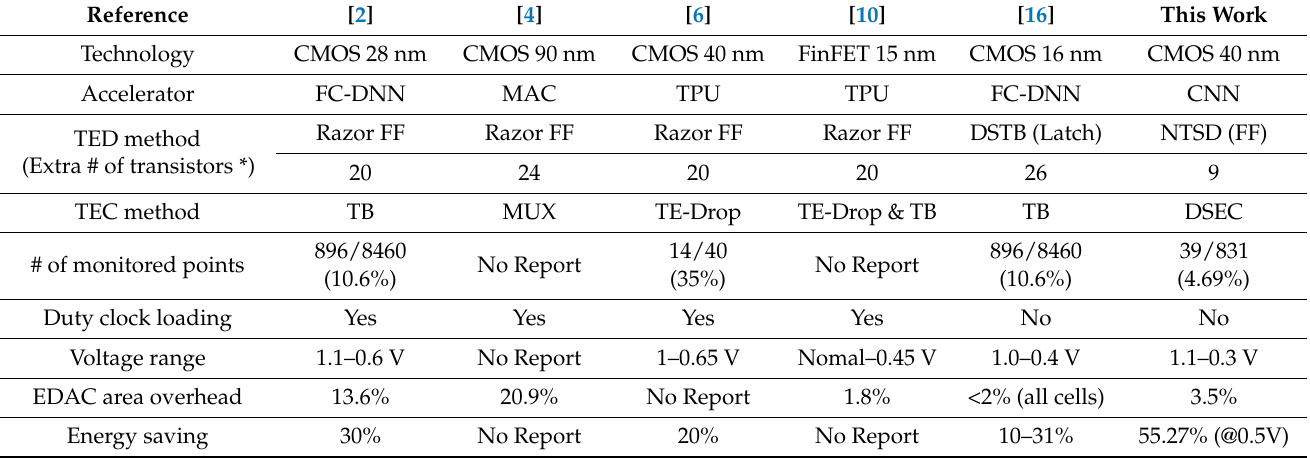
Figure 10. The results of 10 K MC simulations: ( a ) at 1.1 V, 500 MHz; ( b ) at 0.6 V, 100 MHz; ( c ) at 0.4 V, 5 MHz; ( d ) at 0.3 V, 1 MHz. Table 5. The characteristics of the proposed ETFF design and other EDAC designs applied in NN